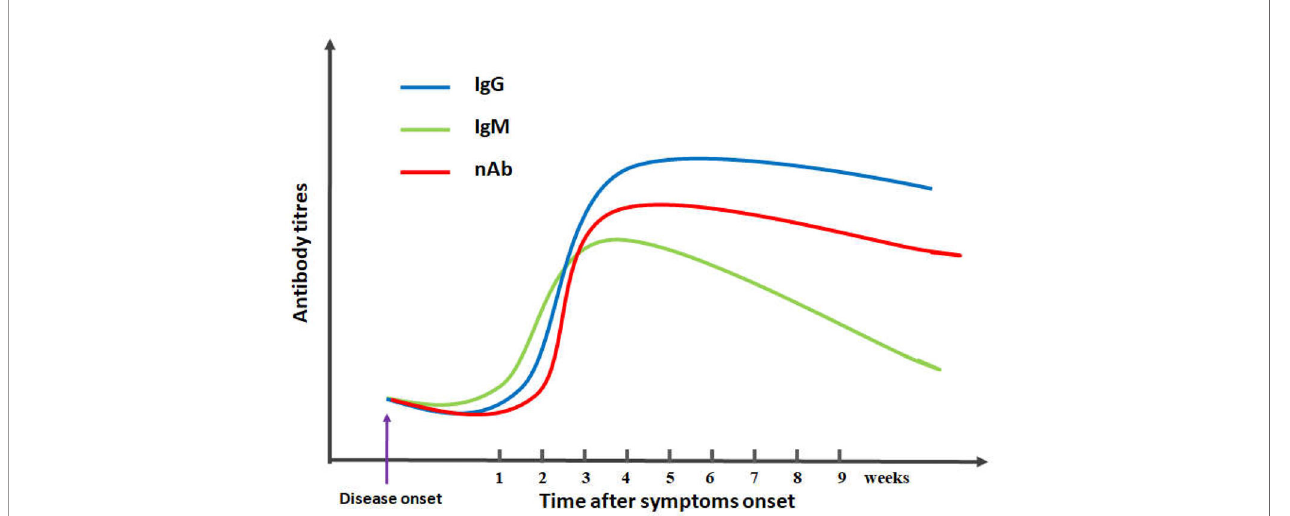
FIGURE 1 | Schematic diagram of antibody kinetics in COVID-19 patients. IgG/IgM/nAb indicates IgG antibodies/IgM antibodies/neutralizing antibodies,